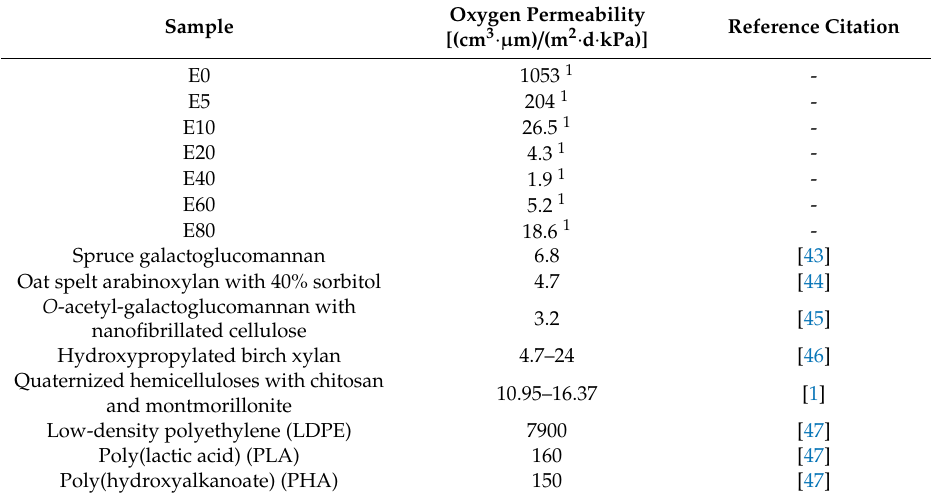
Table 3. Comparison of oxygen permeability of the packaging films in literatures and this work.